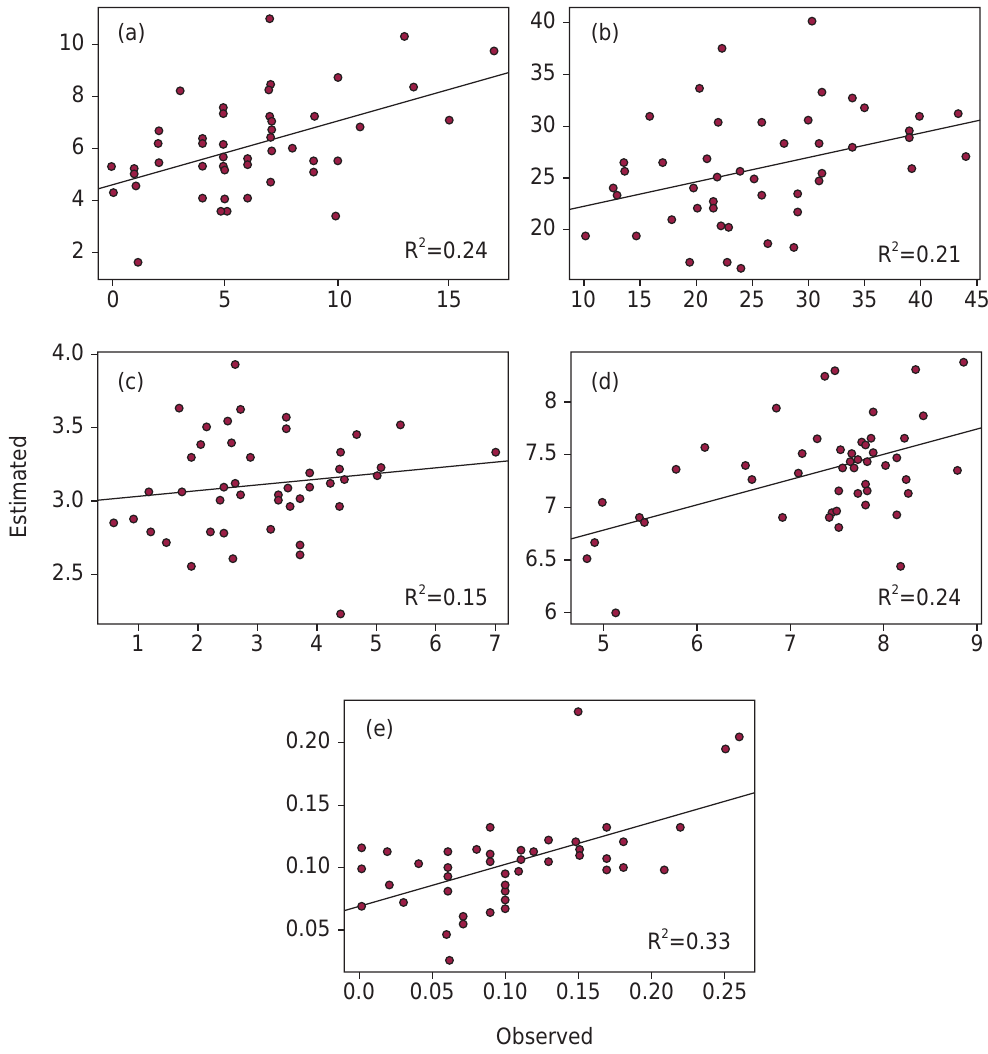
Figure 2. Relation between the estimated and observed values of clay (a), sand (b), pH (c), potassium (d), and soil organic carbon